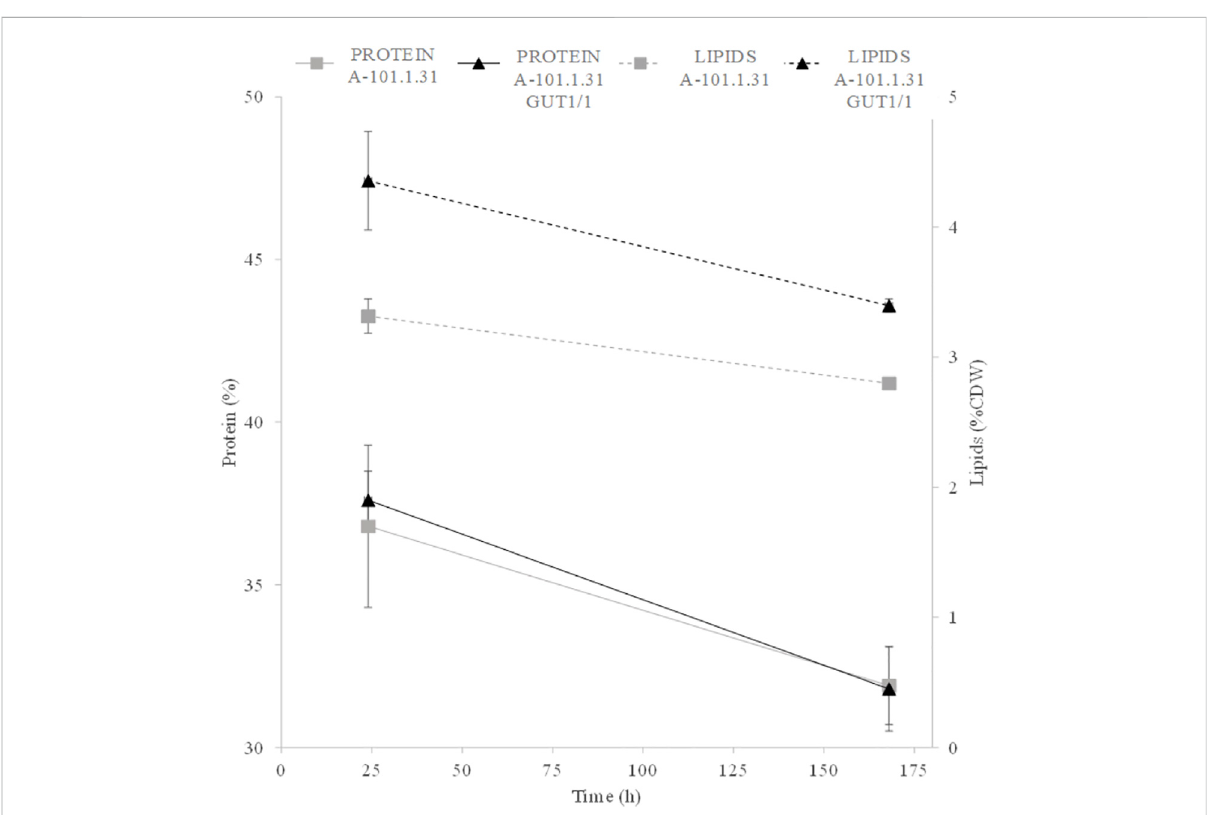
FIGURE 6 Protein (solid line) and lipid (dotted line) contents during kynurenic acid production by the Y. lipolytica A-101.1.31 ( ■ ) strain and mutant Y. lipolytica A-101.1.31 GUT 1/1 strain ( ▲ ) growing on waste glycerol and soybean molasses.